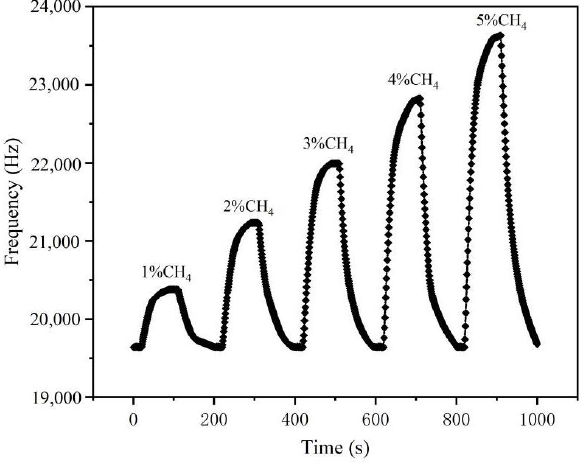
Figure 10. Frequency response recovery curve for 0 – 5% CH 4 .